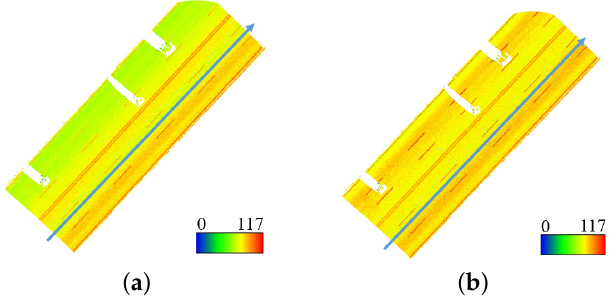
Figure 7. Intensity correction. The color indicates the intensity value and the blue arrow indicates the trajectory. For each point, R is the distance from the point to the trajectory line. ( a ) The uncorrected road points. The intensity of the points far from the trajectory is significantly lower. ( b ) The corrected road points. The impact of the range on intensity is reduced, while the reflective intensity contrast between lane markings and the pavement is